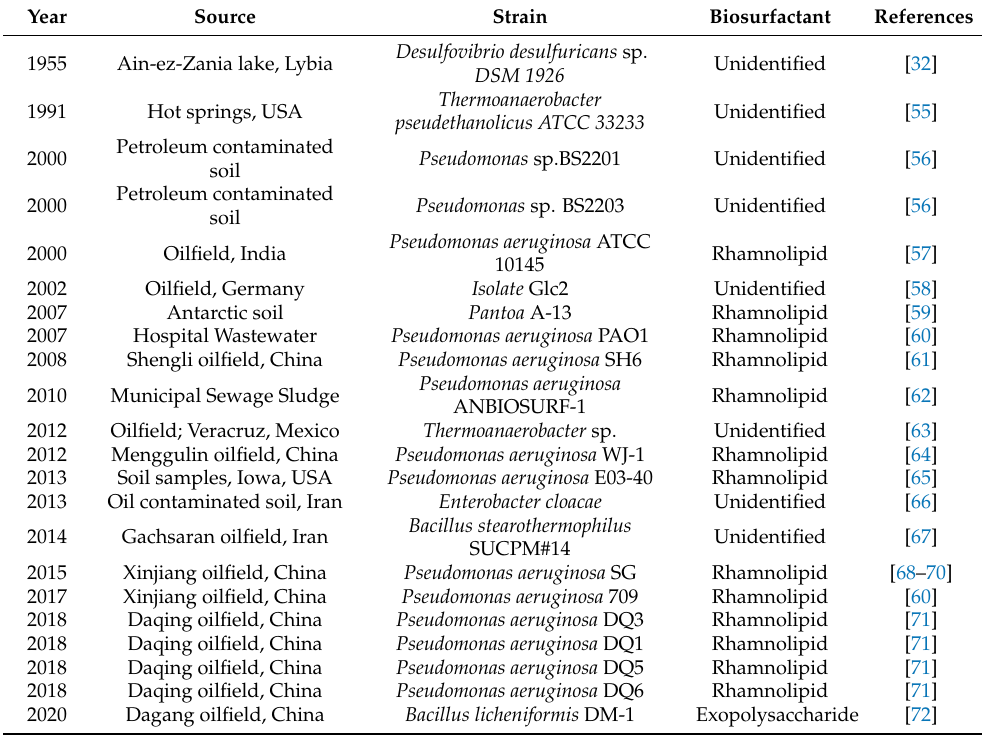
Table 2. Information of biosurfactant-producing strains under anaerobic